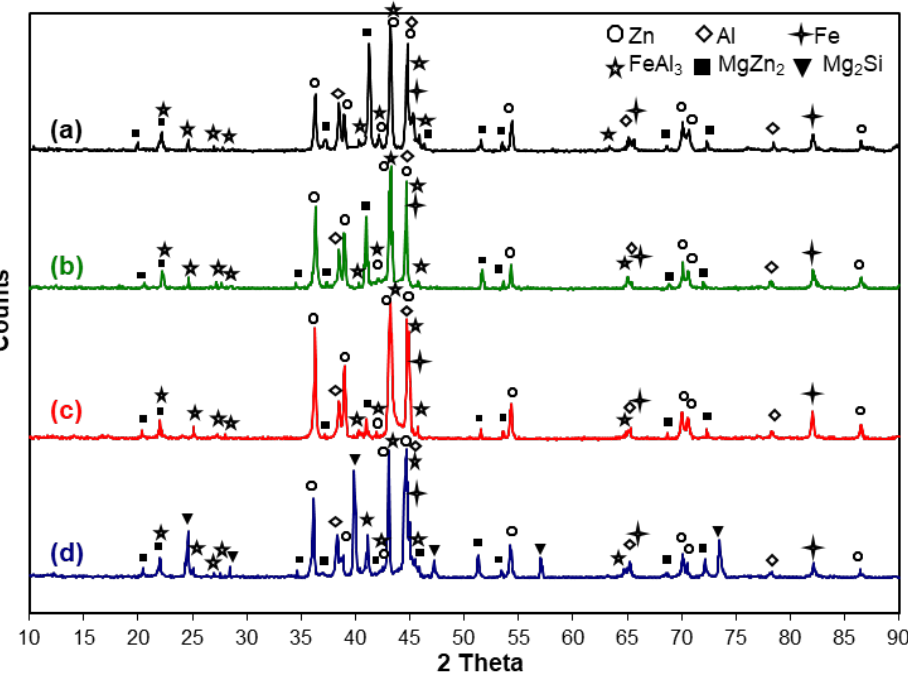
Figure 2. Diffractogram of the oblique ground surface of coatings obtained in the bath: ( a ) ZnAl23Mg3Si0.2; ( b ) ZnAl23Mg3Si0.4; ( c ) ZnAl23Mg6Si0.2; ( d ) ZnAl23Mg6Si0.4.